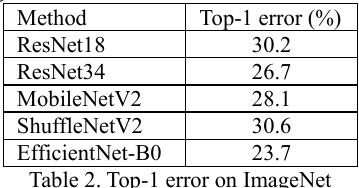
Table 2. Top-1 error on